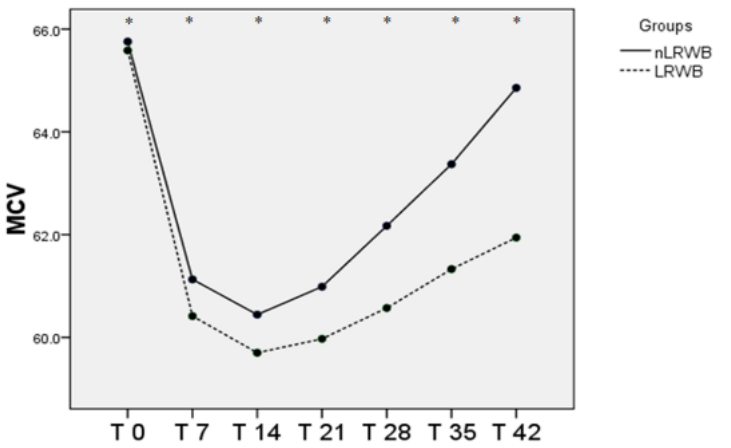
Figure 3. Differences in MCV (mean) measured in nLRWB and LRWB units during the storage period. The days of storage are presented in the x-axis. MCV (fL) is presented in the y-axis. Asterisks * p < 0.05. The RDW increases during the storage in both groups, in particular, significantly from T28 to T42 with no differences between LRWB and nLRWB units (Table 1, Figure 4).